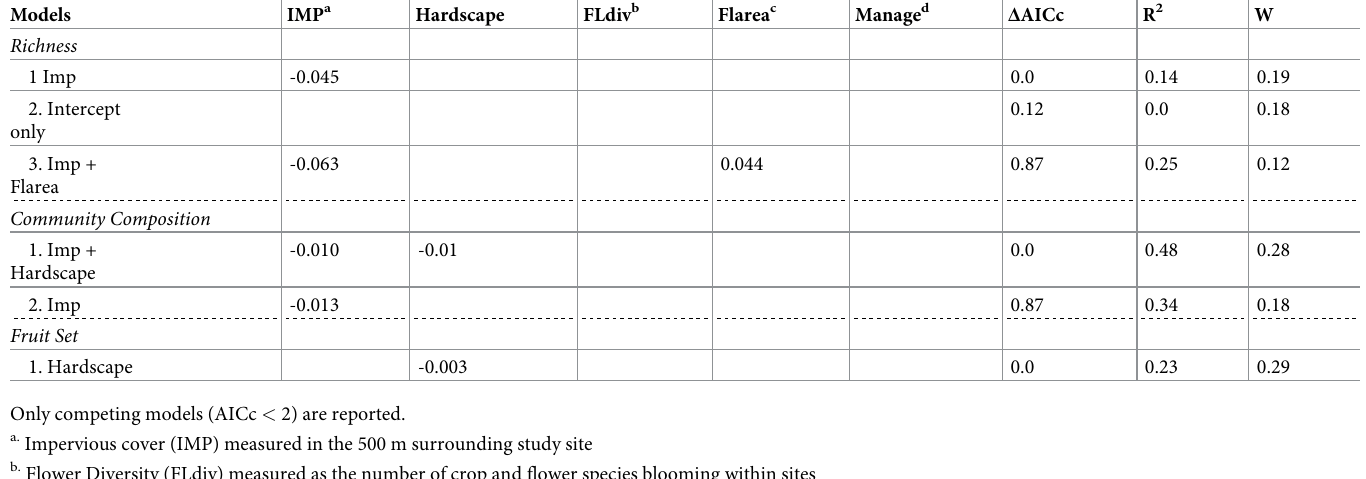
Table 3. Model selection results for bee richness (rarefied), community composition, and fruit set. Models